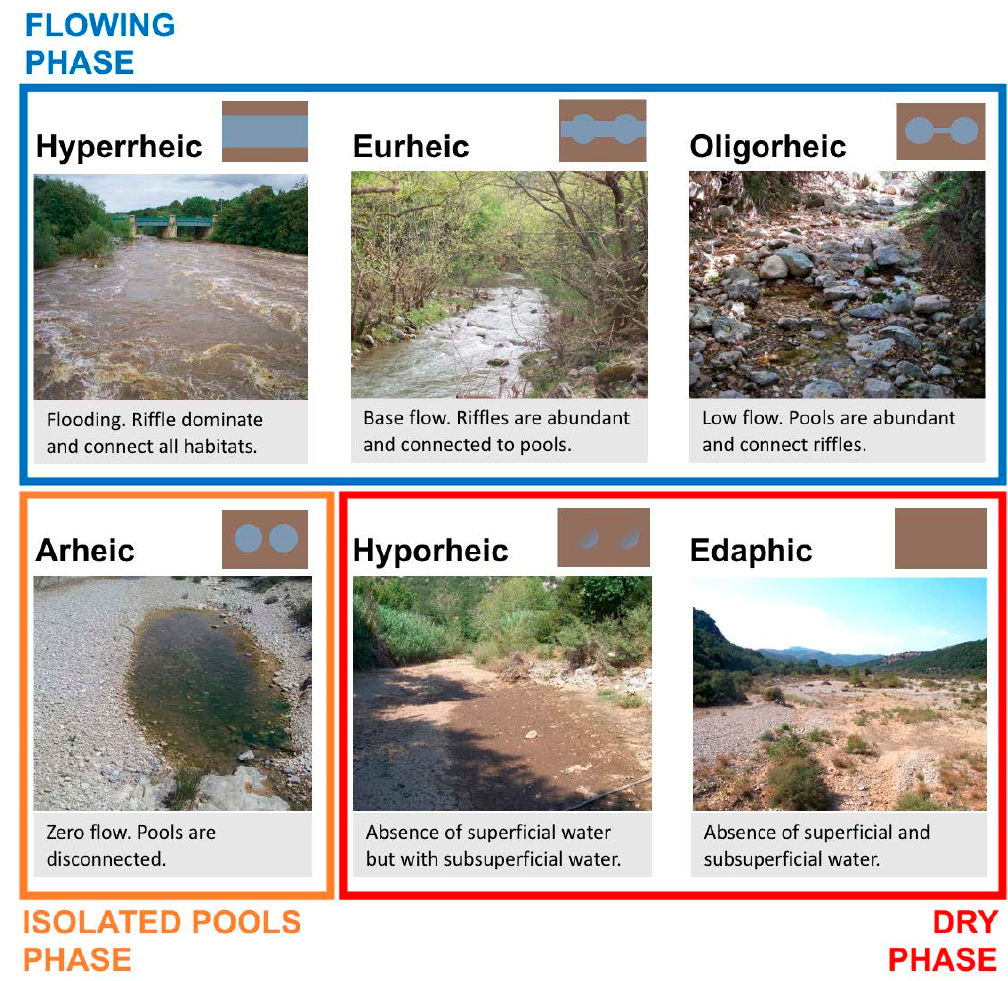
Figure 1. Aquatic states for temporary rivers according to Reference [10] and their simplification in phases [12,13]. Photo credits: MIRAGE and TRivers projects.